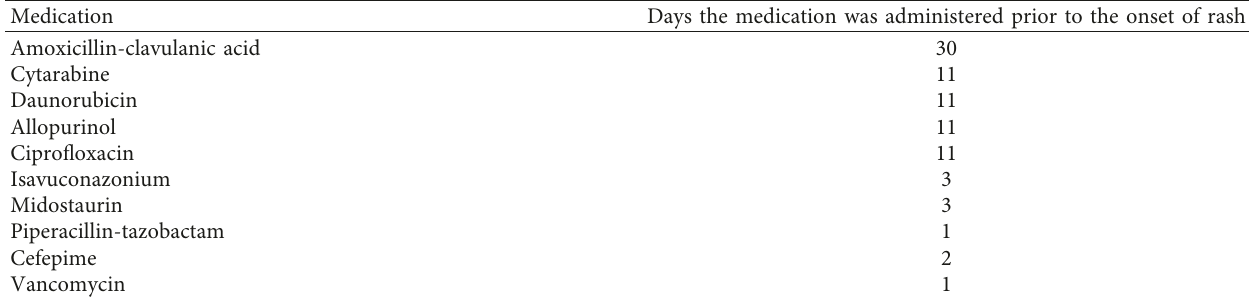
Figure 2: Microscopic view of the pathological specimen from skin biopsy: spongiosis with focal intraepidermal vesiculation as well as papillary dermal edema with upper dermal neutrophilic and lymphocytic inflammation with extravasated erythrocytes. Table 1: Drug administered to the patient prior to the onset of rash (none has been reported to be associated with Sweet’s syndrome except midostaurin).